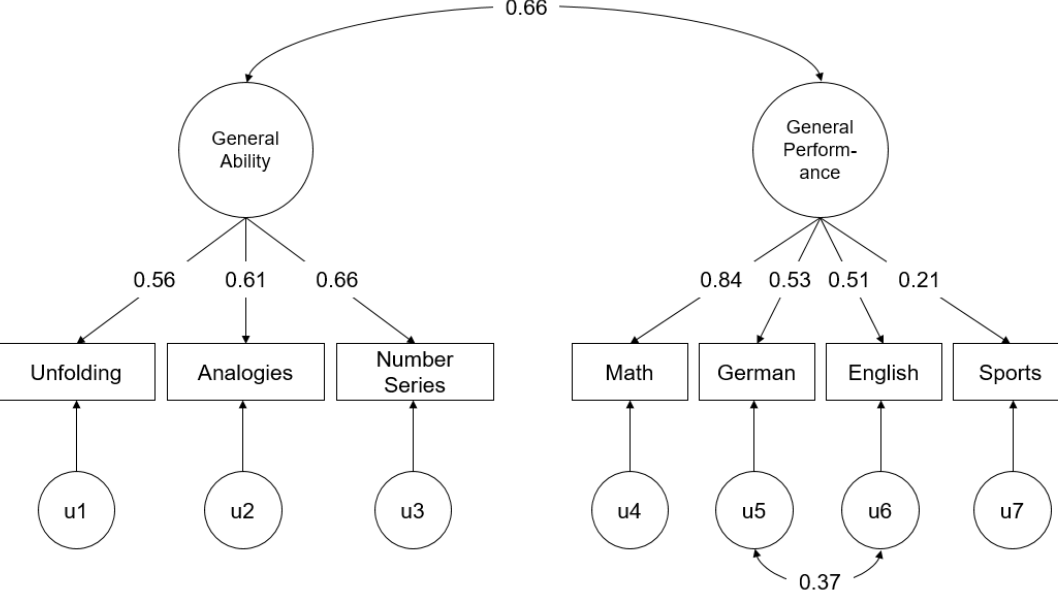
Figure 1. Fully standardized parameter estimates of the structural equation modeling (SEM) model between general ability and general academic performance. All parameter estimates significant at p < 0.01.